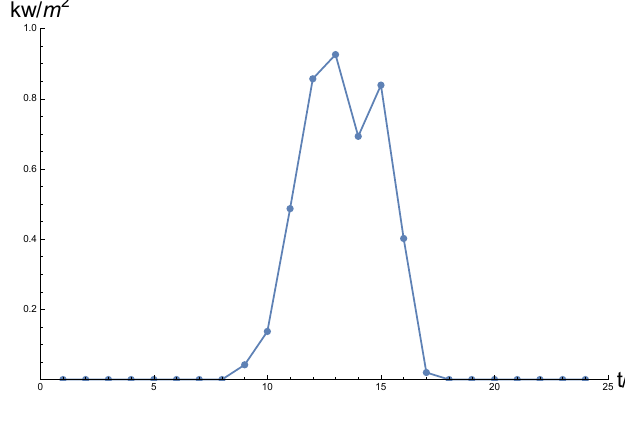
Figure 5. 24-hour ahead solar irradiation forecast.